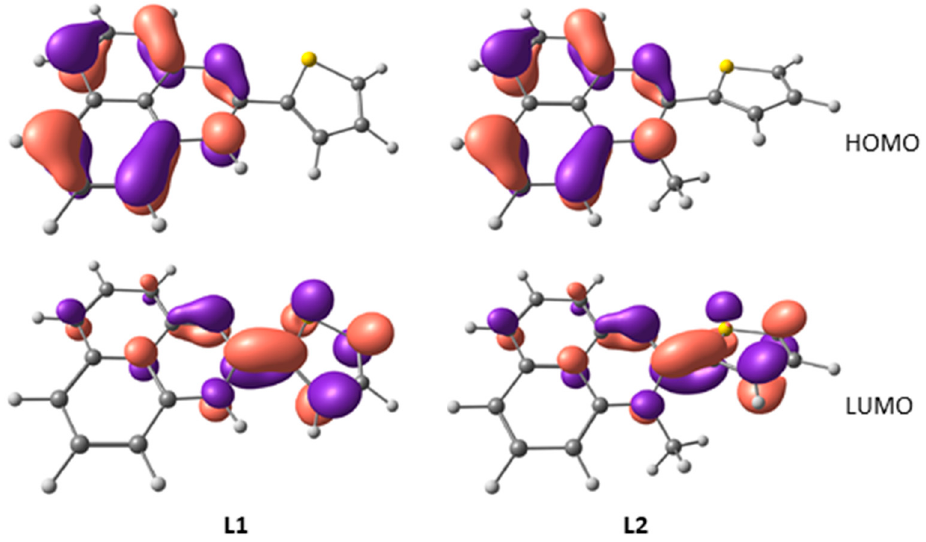
Figure 4. Frontier molecular orbitals in the optimized structures of 1-H-2-(2-thienyl) perimidine ( L1 ) and 1-methyl-2-(2-thienyl)perimidine ( L2 ).